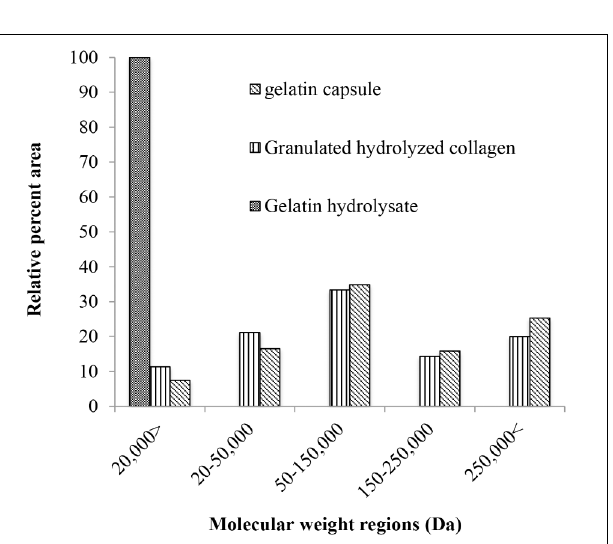
FIGURE 6 | Molecular weight distribution of hydrolyzed collagen by type, reported in relative area percent of the five molecular weight regions the high molecular weight fraction, the beta fraction, the alpha fraction, the sub-alpha fraction, and the low molecular weight fraction of the size exclusion elution